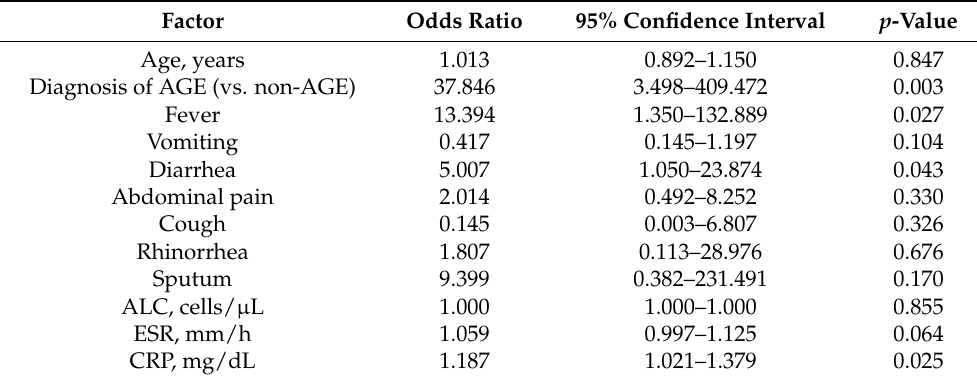
Multivariate analysis for significant factors associated with the identification of invasive